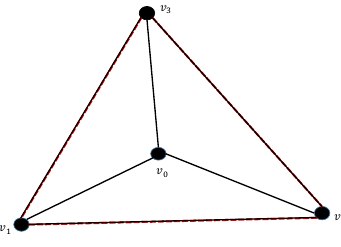
Figure 1. The star of v 0 in complex K